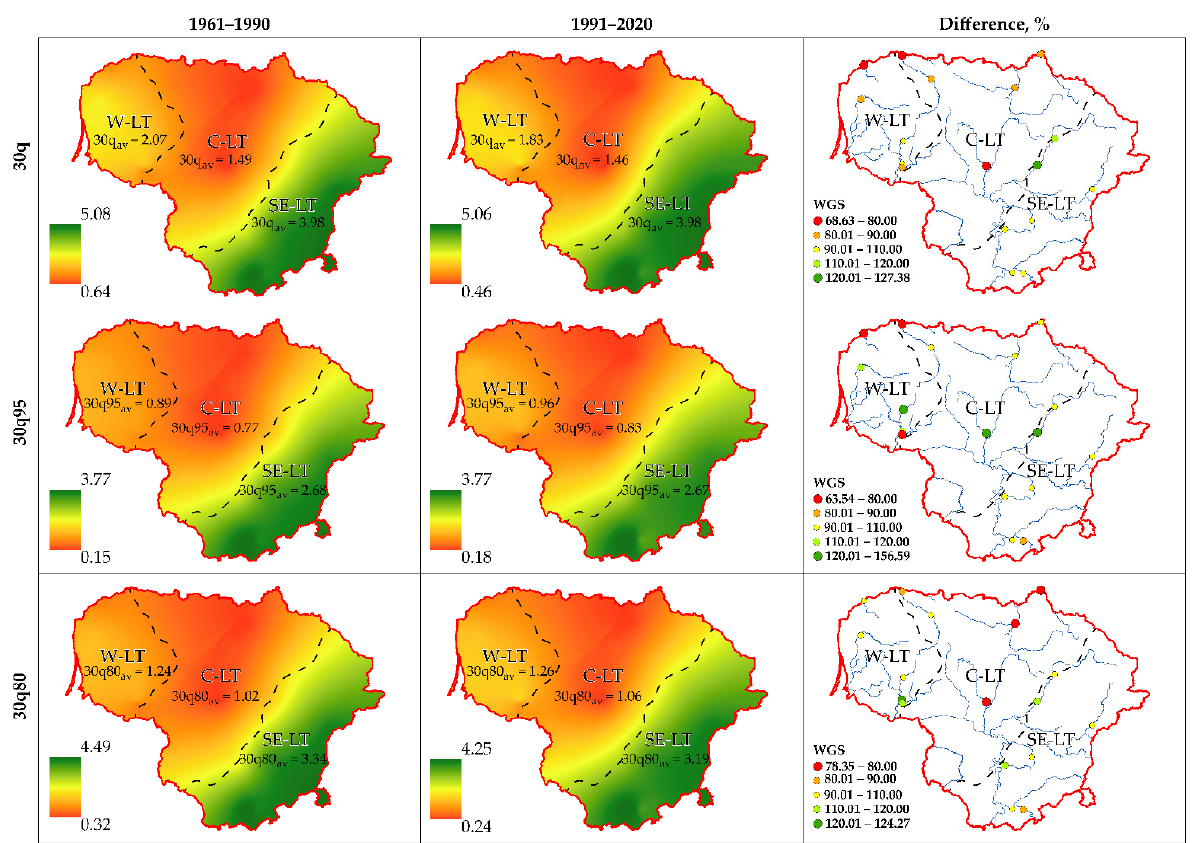
Figure 4. Distribution of low-flow indices (30q, 30q95, 30q80) in the different hydrological regions in 1961 − 1990 and 1991 − 2020, and the difference between low-flow indices in the two periods. Further details on the established differences of low-flow indices in 17 WGSs in 3 hydrological regions are provided in Figure 5. The figure shows differences in the indices both over time and across regions. The highest indices were estimated in the SE-LT re- gion, and the lowest were in the C-LT region. Figure 5. Temporal changes of low-flow indices in three periods: ( a ) 30q, ( b ) 30q95, and ( c ) 30q80 . In Figure 4, the differences of the low-flow indices between the two periods (1961 − 1990 and 1991 − 2020) and three hydrological regions are given as percentages. Only differences greater than 20% were taken into account in the analysis. In the W-LT region, a significant decrease in 30q (by 27%) over the last thirty years was estimated for BAR. In the C-LT region, for SUS and VEN2, a considerable difference